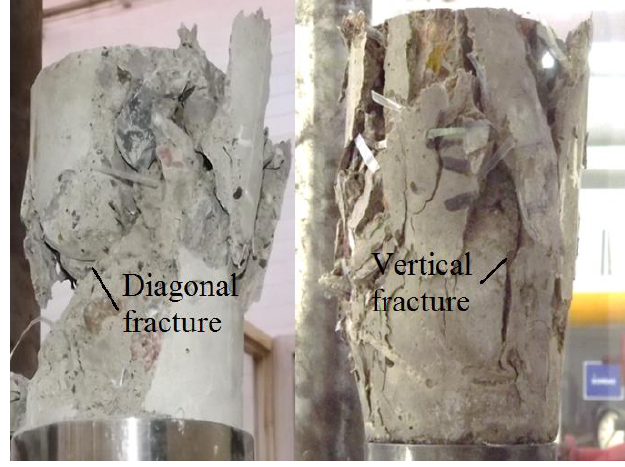
Figure 6. Compressive failures on R/PET-FRC samples.